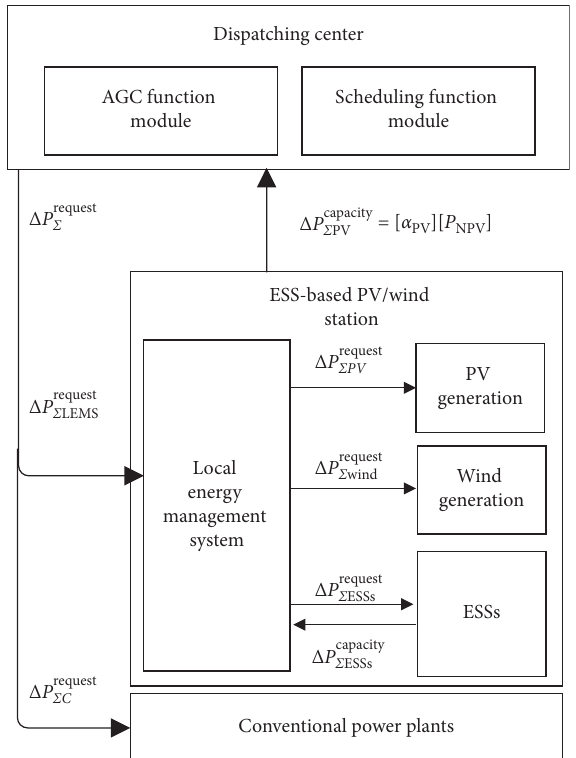
Figure 2: Control structure of ESS-integrated PV/wind station- based AGC auxiliary